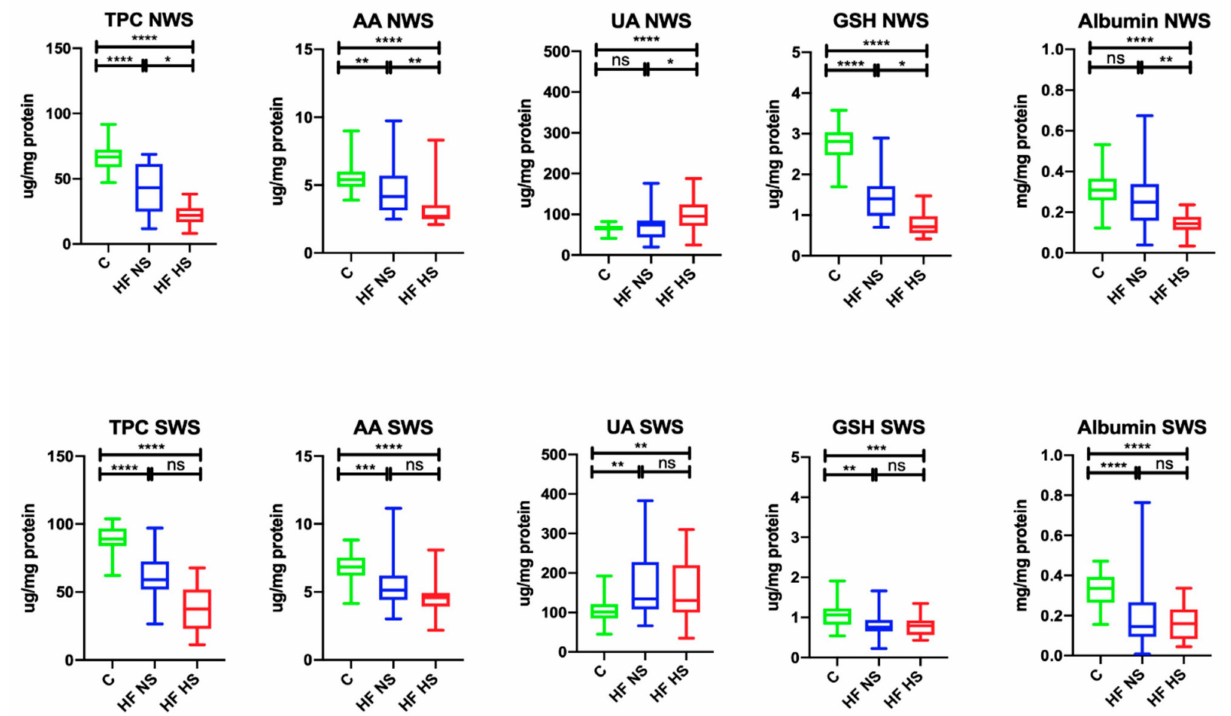
Figure 1. Salivary antioxidants in non-stimulated and stimulated saliva of HF patients and the control group.